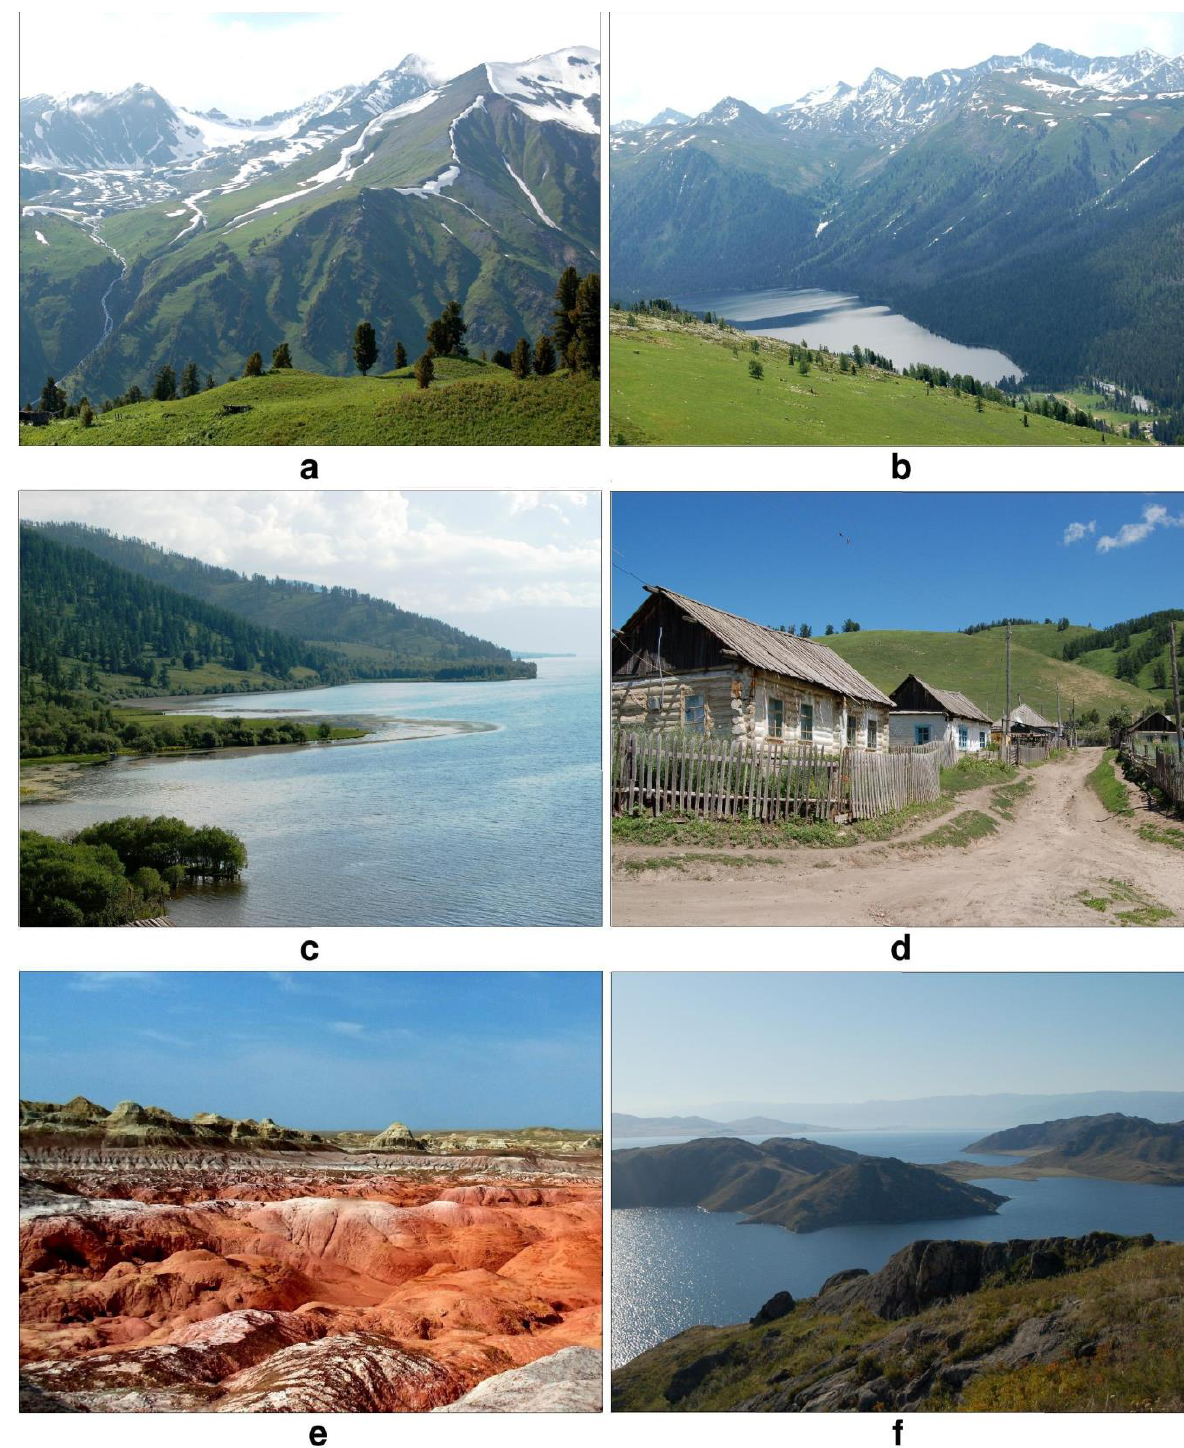
Figure 6. The Southern Altai landscapes and geosites. ( a ) the Katun’ Range (4506 m asl.), ( b ) Rakhmanovskiye Klyuchi Lake (1750 m asl.); ( c ) Lake Markakol (1485 m asl) at the foots of the Sarym-Sakty Range (3373 m asl.); ( d ) a rural mountain setting, Urumkhaika—a typical rural village in the study area with a Late Pleistocene glaciofluvial terrace in the background (Lake Markakol Nature Reserve; ( e ) the Kiin-Kerish Mesozoic badlands; ( f ) arid rocky landscape flooded by the Burkhtarma Reservoir; ( a , b ) the Katon-Karagay recreational area; ( c , d ) the Lake Markakol recreational area; ( e , f ) the Kurchum recreational area (photographs by Jiri Chlachula).